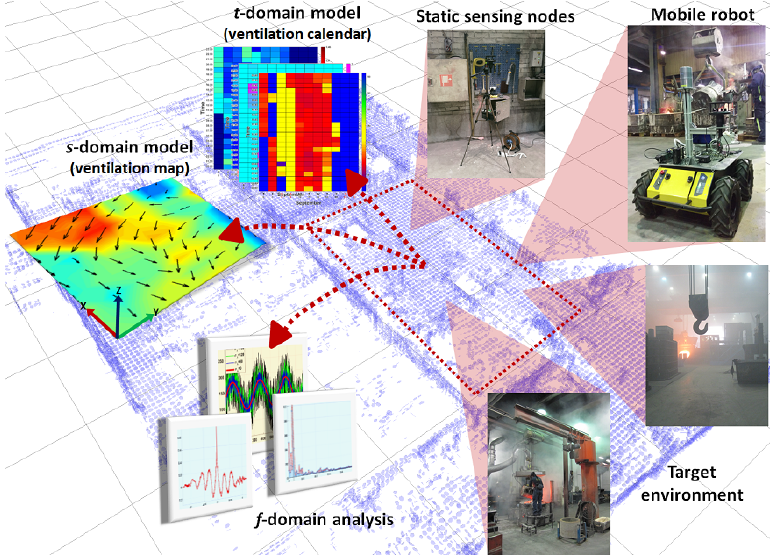
Figure 1. Block diagram of the proposed ventilation characterization system. Data from mobile robots and sensing nodes are combined to produce temporal, spatial and frequency domain